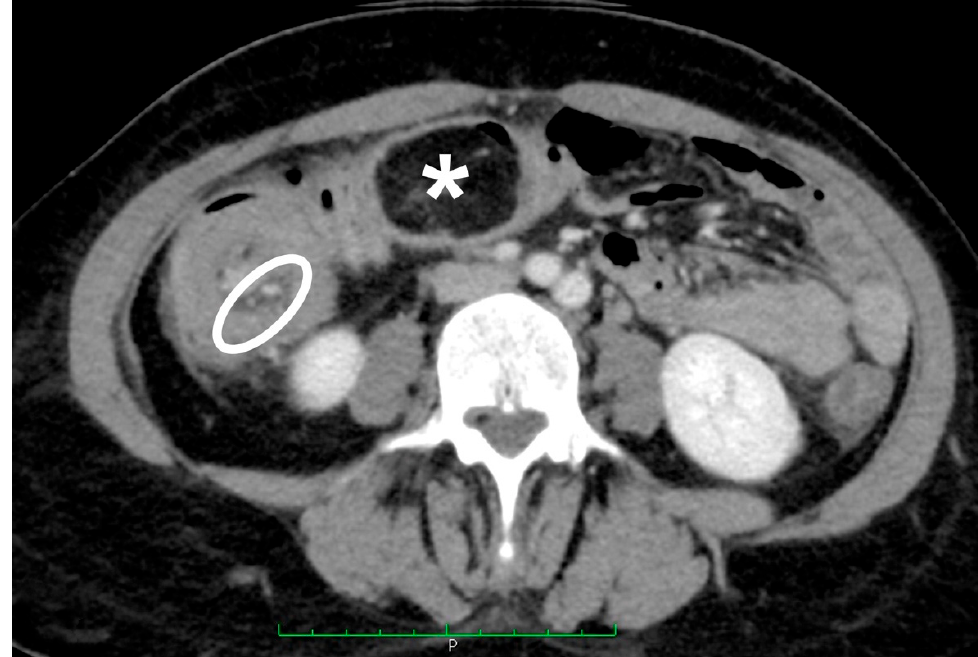
Figure 3. Axial CT scan of the abdomen in portal/venous phase. Circumferential thickening in ileocolic intussusception caused by the lipoma; note the mesenteric fat and vessels (white oval) and the terminal ileum associated with the intussuscipiens (asterisk).